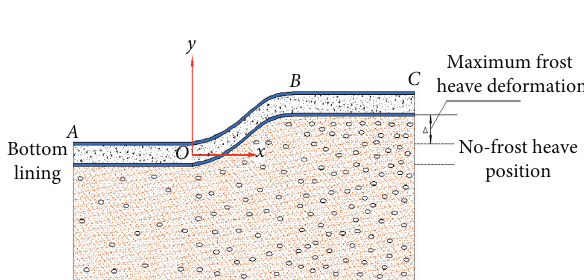
Figure 1: Schematic diagram of nonuniform frost heave defor- mation of bottom